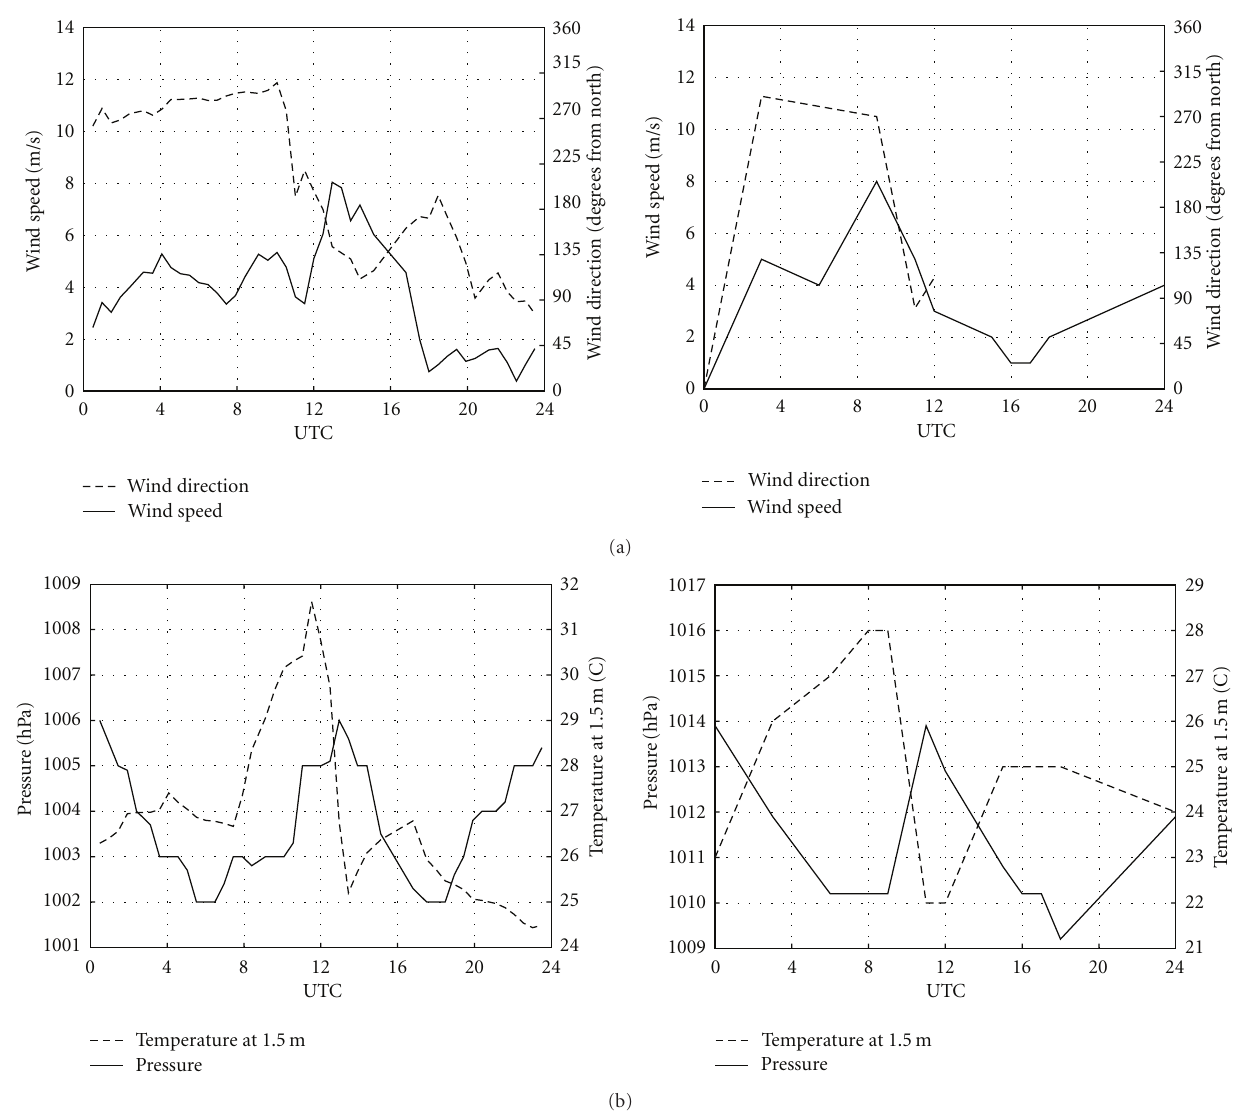
Figure 7: (a) Double y -axis plots containing an 11 September 2006 time series of wind speed in ms − 1 and wind direction in degrees from north for Kawsara and Cap Skirring, Senegal. (b) Double y -axis plots containing an 11 September 2006 time series of pressure in hPa denoted by the solid line and 1.5m temperature in ◦ C denoted by the dashed